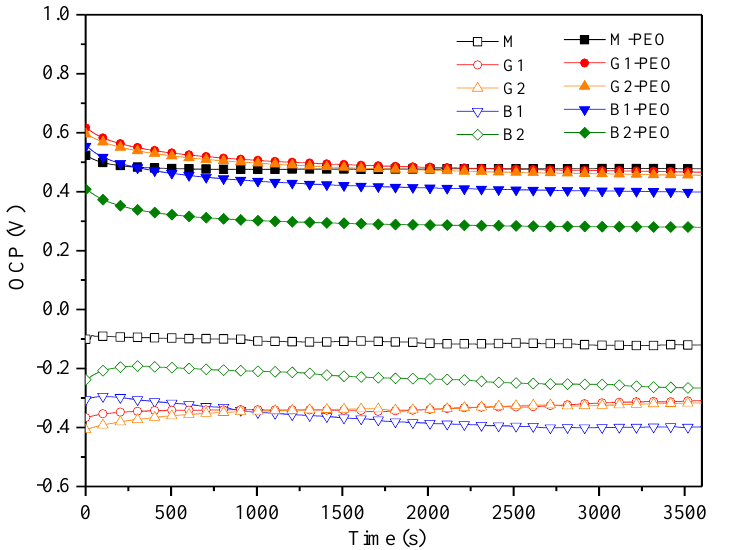
Figure 13. Evolution of the open circuit potential (OCP) over 1 h of immersion in modified α -MEM solution.